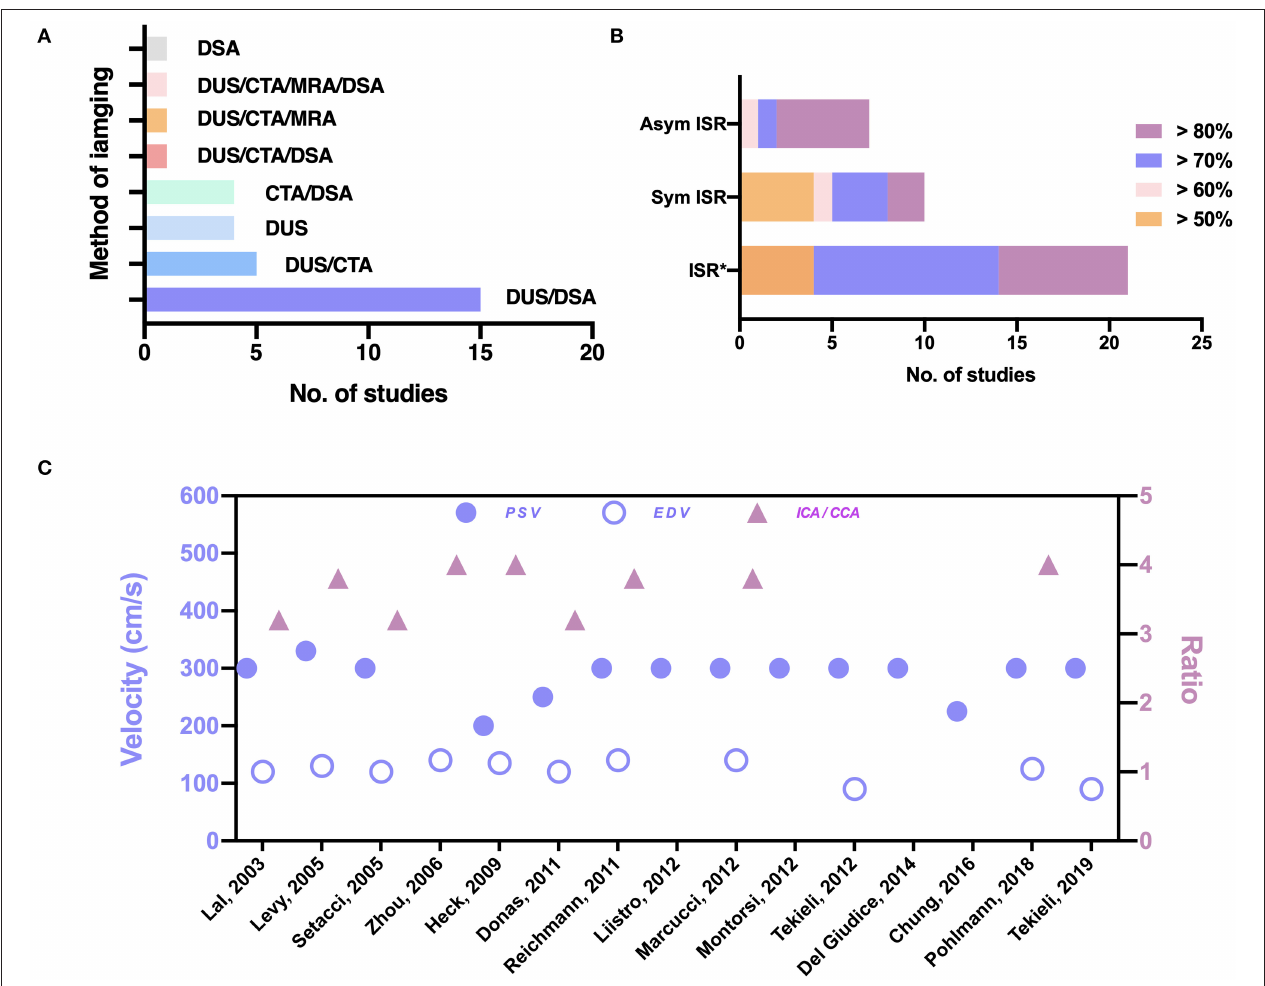
FIGURE 2 | The imaging techniques and indications in the 35 studies. (A) Imaging techniques used for the diagnosis of ISR. (B) Criteria for the treatment of ISR. Asterisks ( * ) indicate a category of ISR not reported in the studies. (C) Thresholds of PSV, EDV, and ICA/CCA the in diagnosis of ISR. Sym, symptomatic; Asym, asymptomatic; DUS, duplex ultrasonography; DSA, digital subtraction angiography; CTA, CT angiography; MRA, MR angiography; EDV, end diastolic velocity; PSV, peak systolic velocity; ICA/CCA, internal to common carotid artery peak systolic velocity